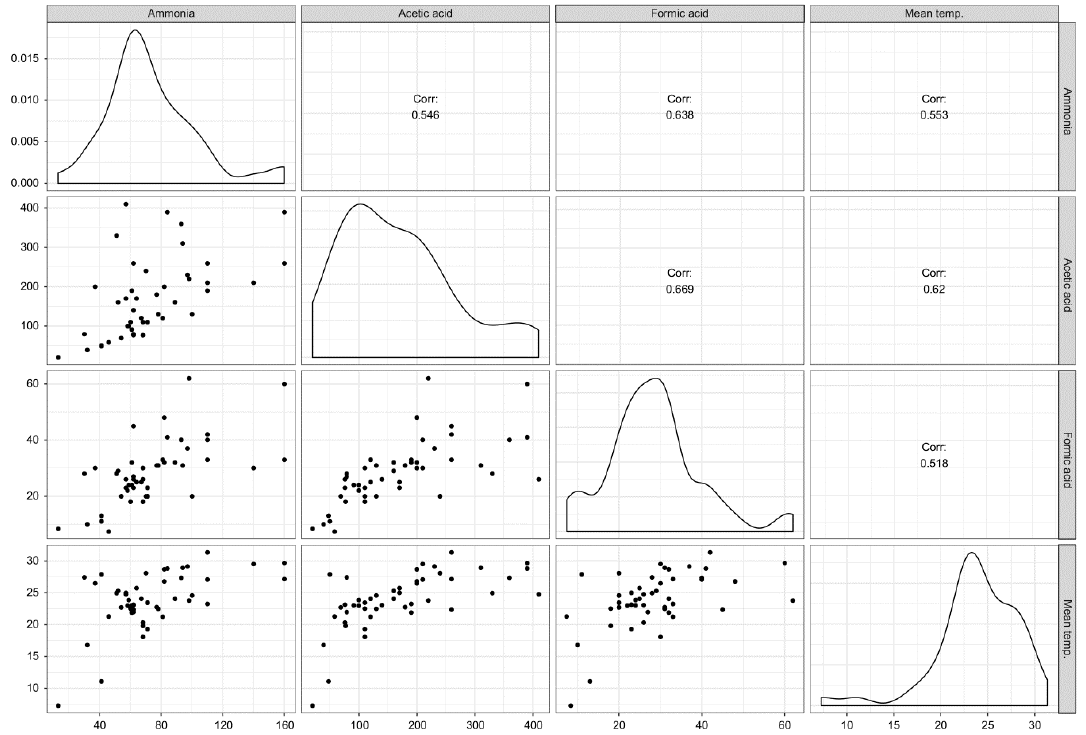
Figure 3. Correlation among acetic acid, formic acid, ammonia, and room temperature. The correlation coefficients are expressed by “ r ,” indicating that there are correlations among them.